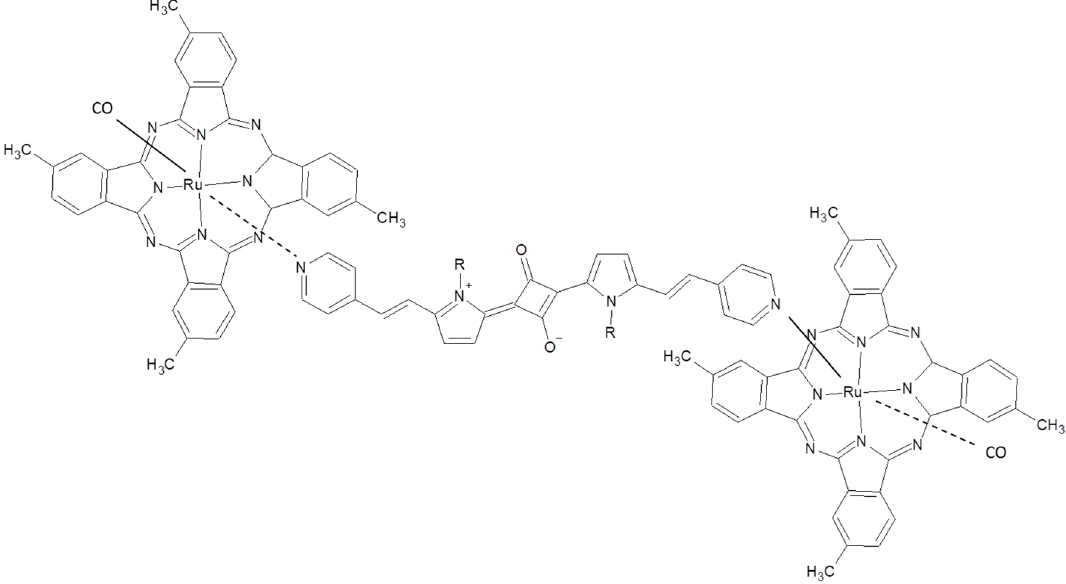
Figure 11. RuPc/squaraine derivative/RuPc photoactive supramolecular assembly reported in [86]. Figure 11. RuPc / squaraine derivative / RuPc photoactive supramolecular assembly reported in